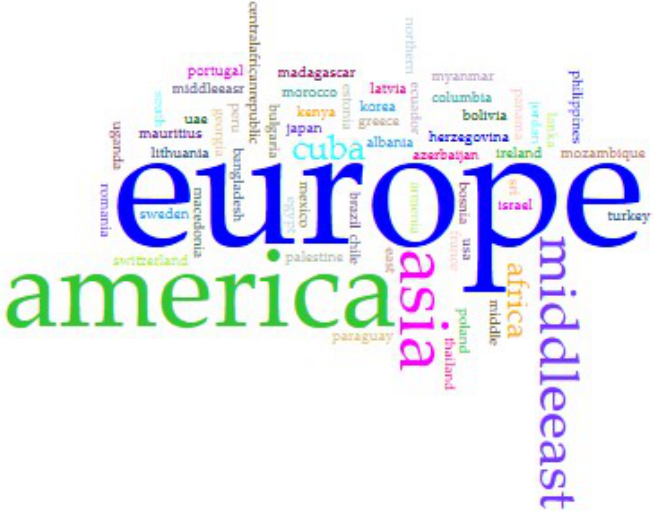
Figure 3. Global Journeys by Francis (until the corona crisis 2020) (own figure, copyright by the